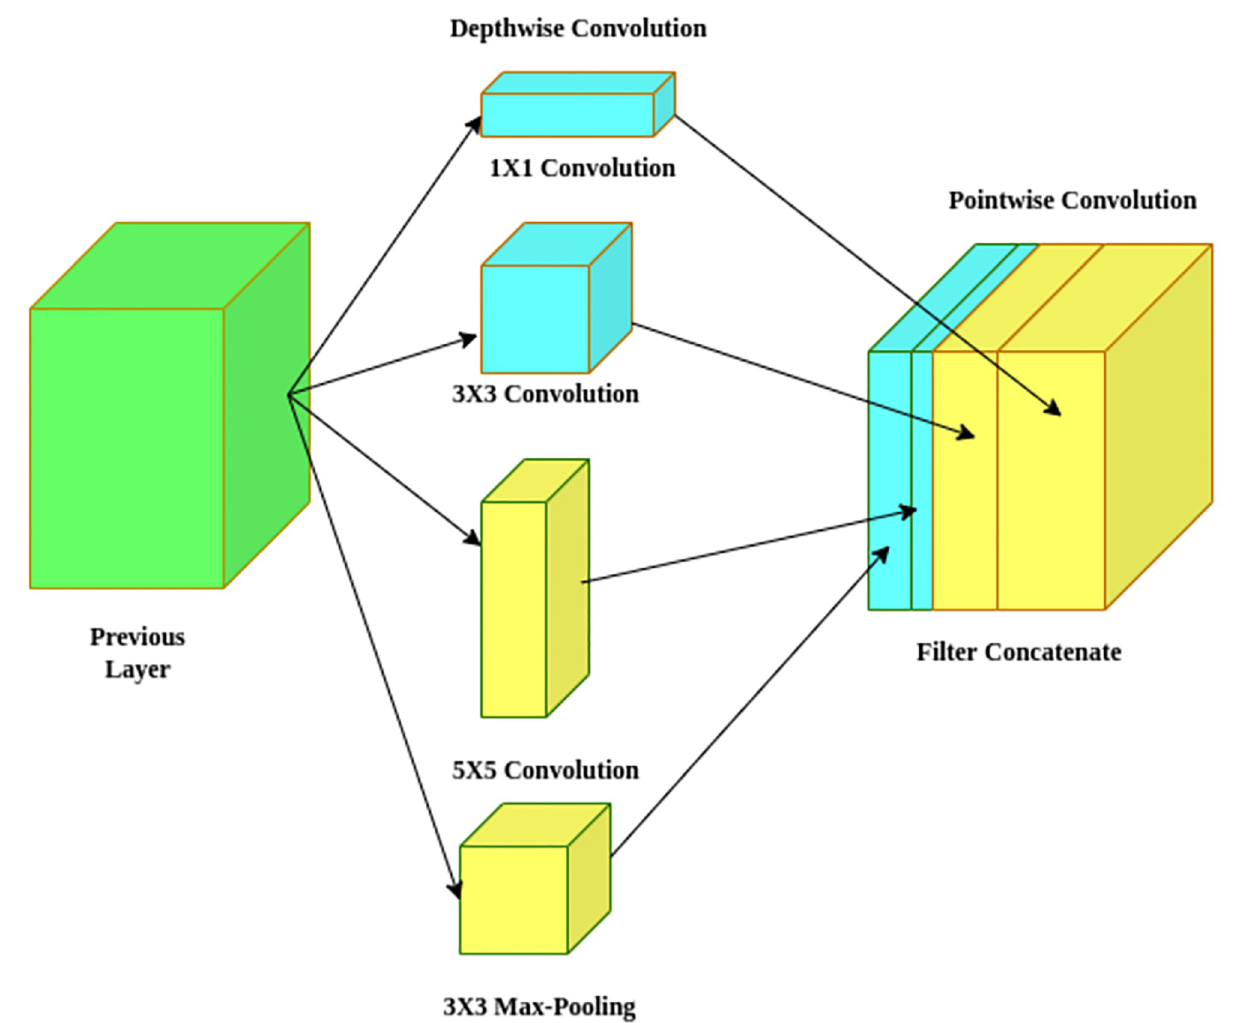
Fig 3. A basic block used of the Xception